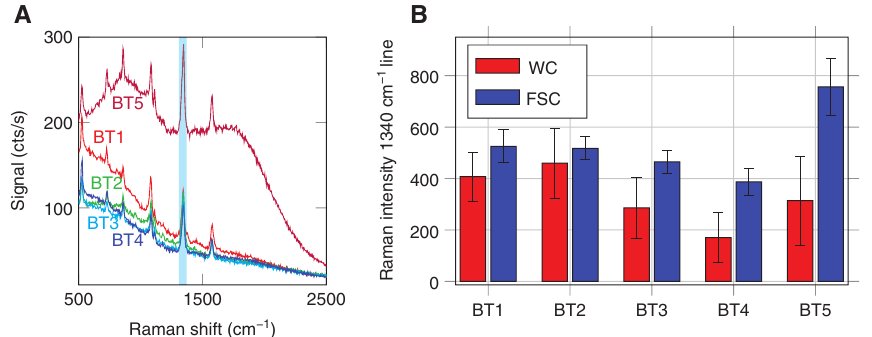
Figure 4: Free-space versus waveguide-excited single-antenna SERS spectra. (A) Raman spectra from five different waveguides with N = 1 antenna on top (BT1, … , BT5), but now the SERS signal from the antenna is excited and collected using a top-down configuration and not through the waveguide. (B) Comparison between the SERS signal of the 1340 cm −1 peak, excited and collected through the waveguide (WC) and through the objective (FSC). The signal values of the FSC measure- ments were re-scaled to normalize them with respect to the excitation power of the waveguide